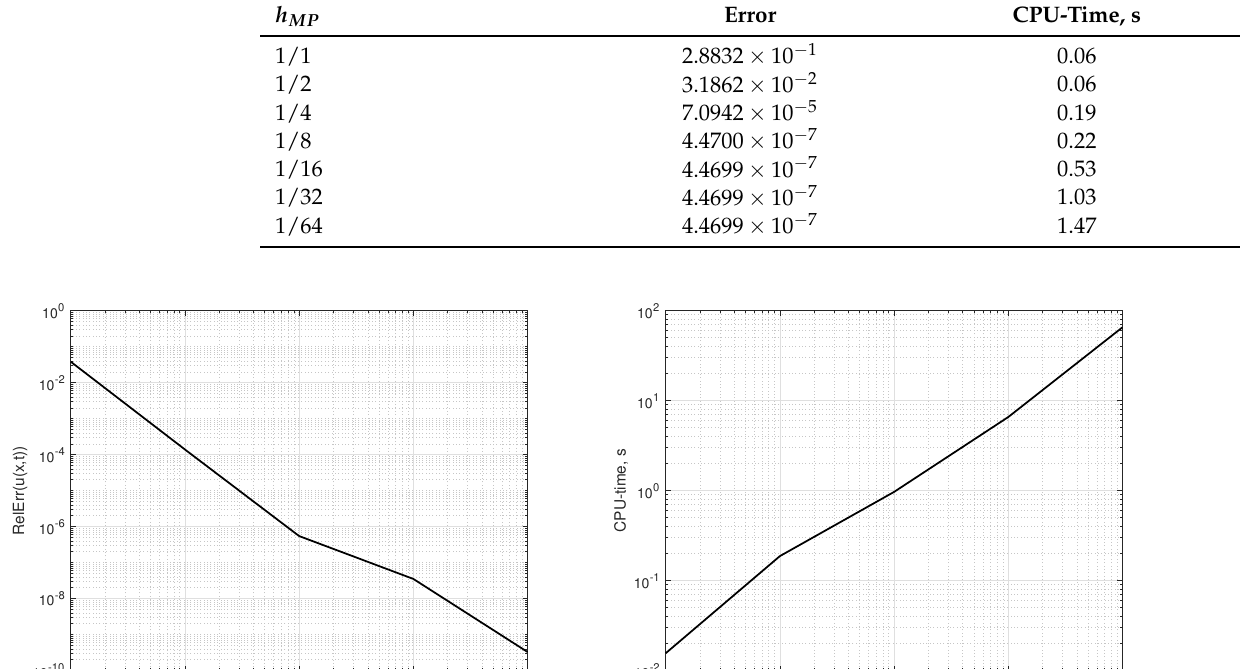
Table 3. The maximum relative error and computational time of the midpoint quadrature rule with respect to step size h MP for Example 1.